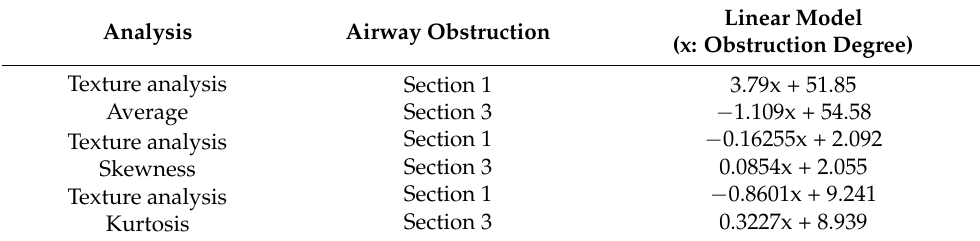
Table 4. Linear model results of texture analysis for degrees of obstruction in accordance with location of